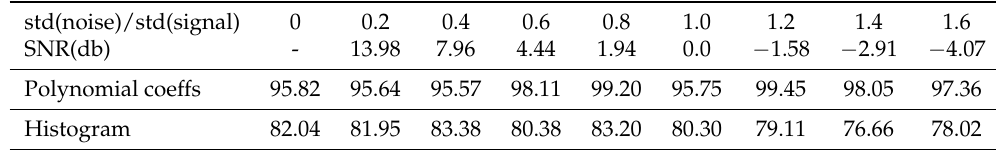
Table 3. Mean Accuracy of 100 runs.